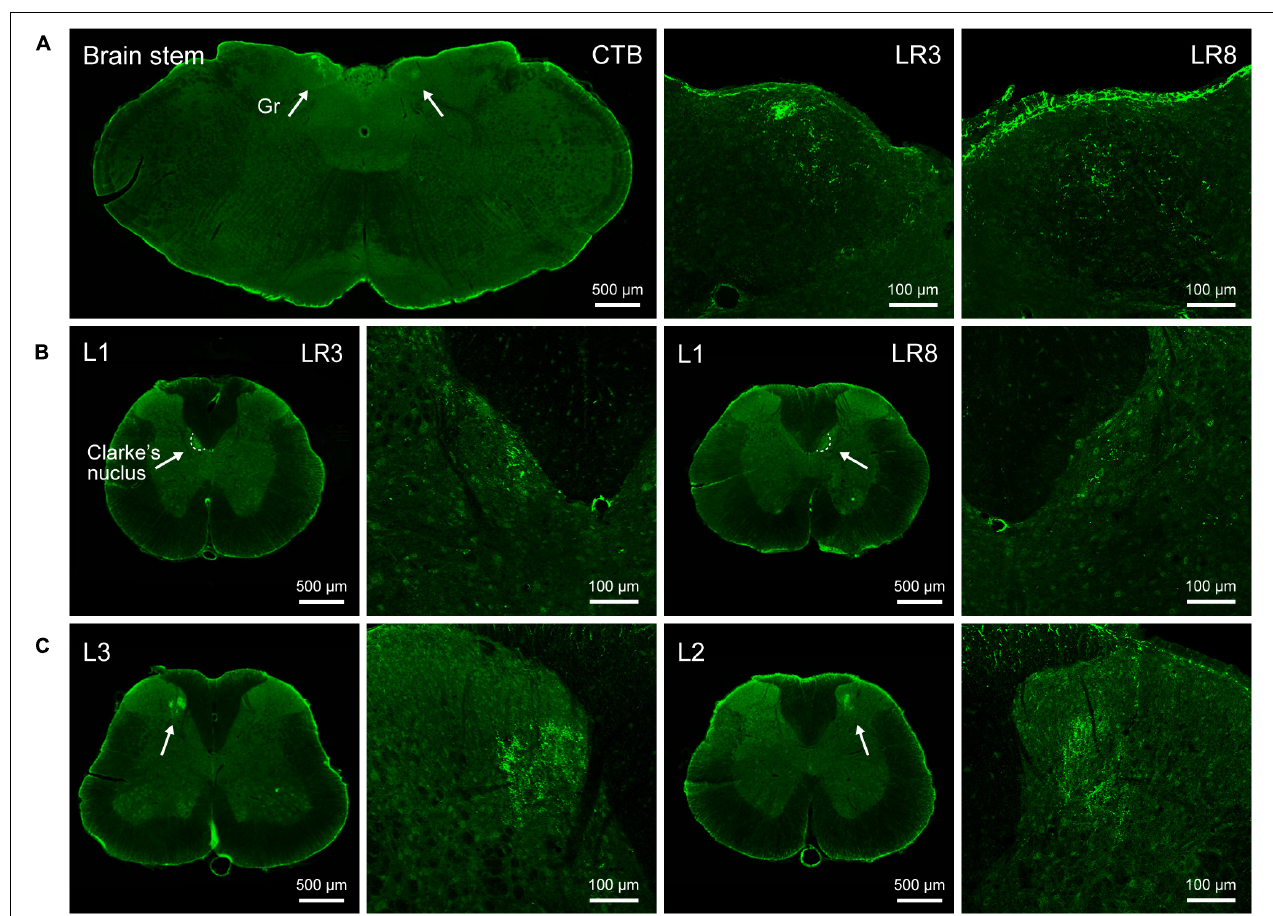
FIGURE 3 | Distribution of the transganglionically labeled axon terminals with cholera toxin subunit B (CTB). (A–C) Representative photos from the brain stem (A) and spinal cord (B,C) showing the CTB labeled axon terminals associated with “Taichong” (LR3, left side) and “Ququan” (LR8, right side) in the gracile nucleus (Gr, A ), Clarke’s nucleus at lumbar (L) 1 segment (B) , and spinal dorsal horns at L2 and L3 segments (C) , their magnified photos (arrowheads) showing the axon terminals in